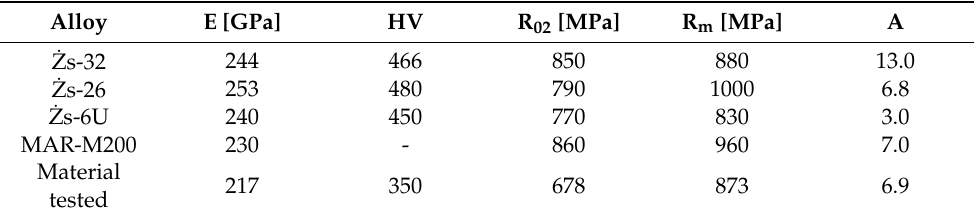
Table 5. Strength properties at room temperature of nickel-based superalloys potentially used to construct the HPT blades and LPT blades of the RD33 engine.